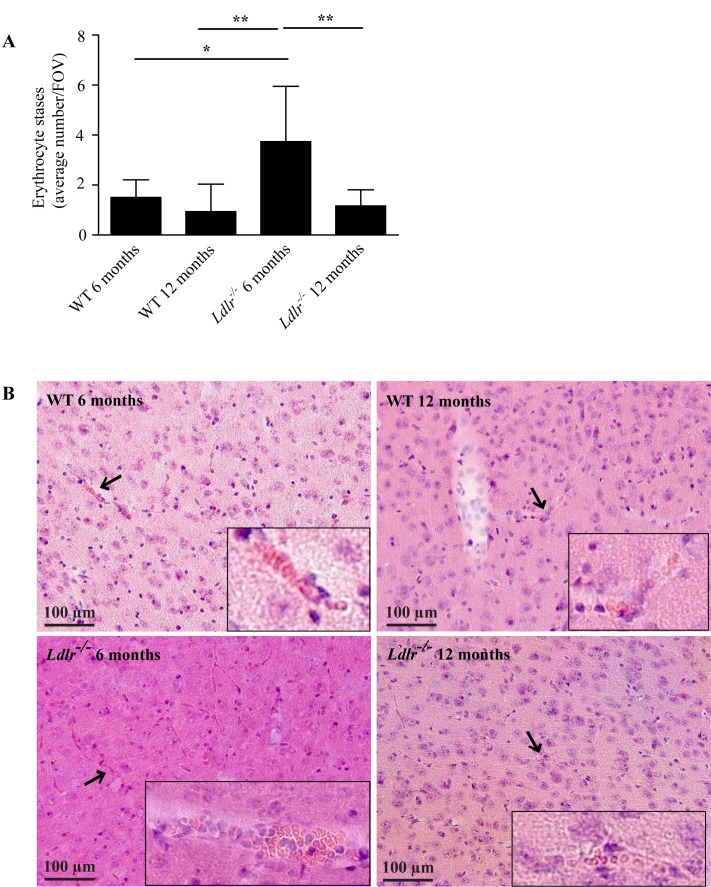
A) Intravascular accumulation of erythrocytes (referred to as erythrocyte stases) in the capillaries and arterioles of 6 and 12 months old WT and Ldlr-/- mice. Importantly, 6 months old Ldlr-/- animals showed the highest number of stases. Analysis of variance with Bonferroni post-hoc test, * P < 0.05, P < 0.01. B) Histological Hematoxylin–Eosin stainings of cortical tissue of 6 and 12 months old WT and Ldlr-/- mice (20x magnification). Erythrocyte accumulations are marked with arrows and accentuated in the inserts with higher magnification (40x). WT, wild-type; FOV, field of view. Error bars indicate standard deviation.